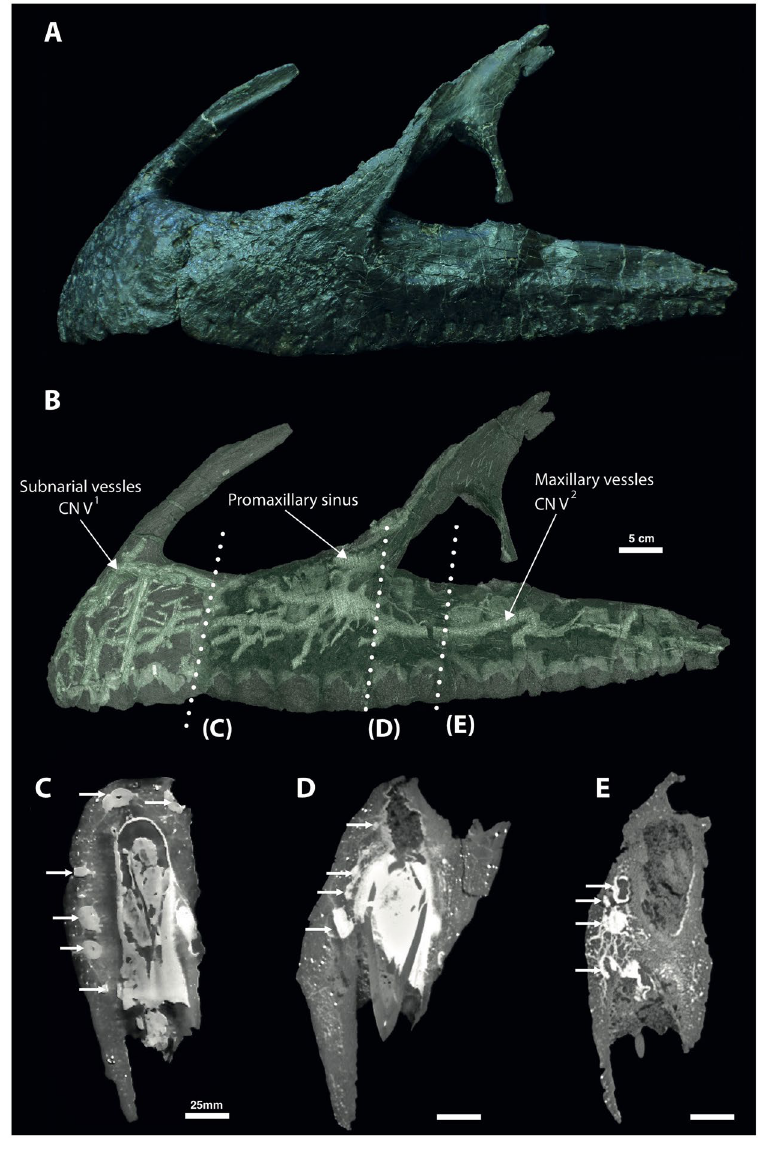
Figure 3. ( A ) Articulated premaxilla and maxilla of Neovenator holotype MIWG 6348 in left lateral view (Credit: Roger Benson). ( B ) Volume rendering of the segmented neurovascular network overlaid on the articulated premaxilla and maxilla. ( C – E ) μ CT virtual sections showing lateral placement of the neurovasculature (white arrows).